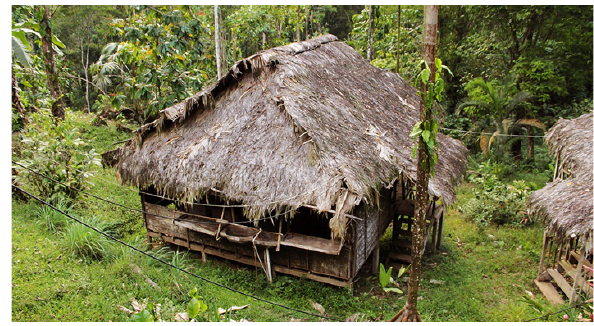
Figure 11. Alakölpa project, in Guabo de Yorkin (Bribri area).